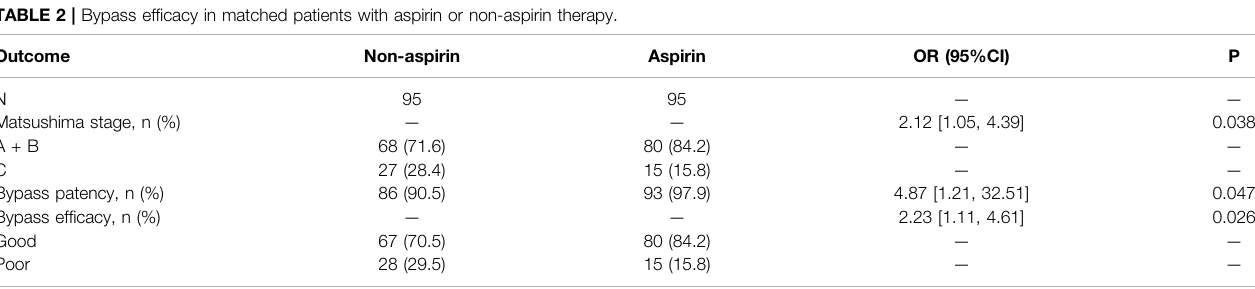
TABLE 2 | Bypass ef fi cacy in matched patients with aspirin or non-aspirin therapy. Outcome